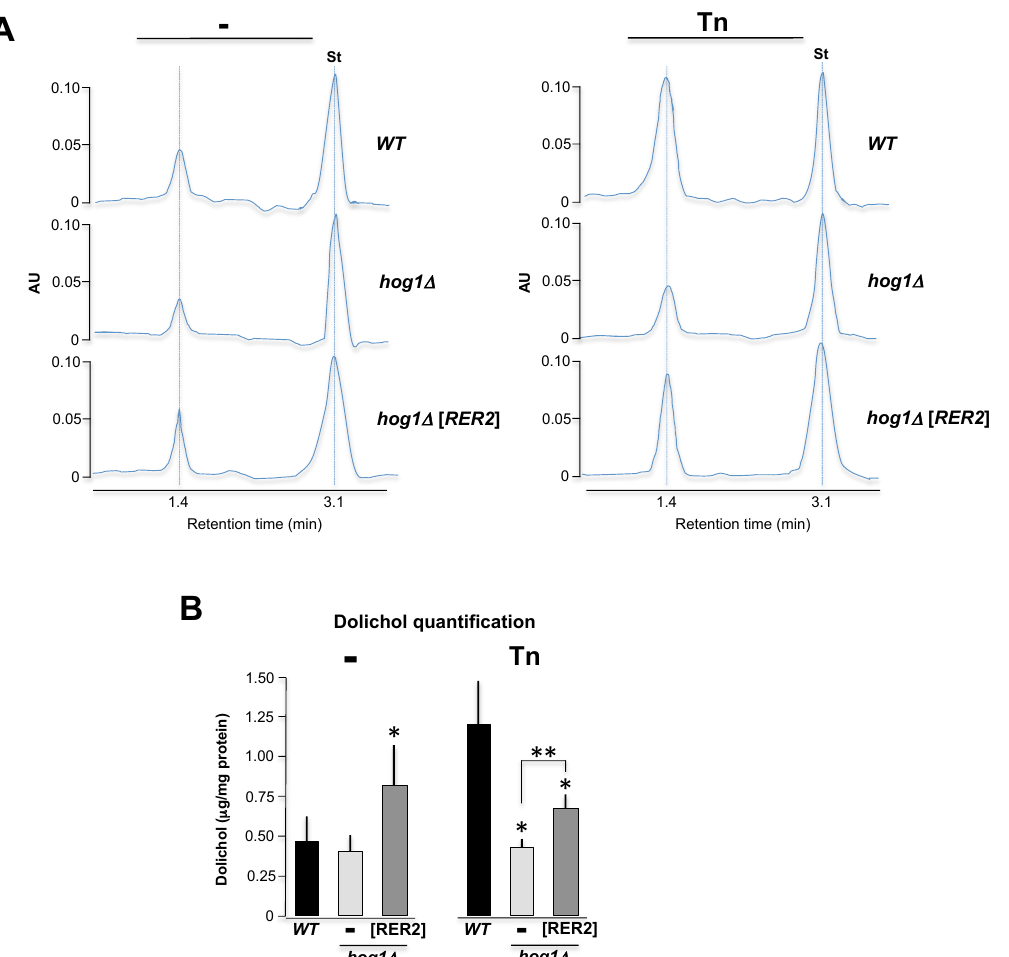
Figure 8. E ff ect of Hog1 inactivation and Tn treatment on the polyprenols concentration. ( A ) HPLC analysis of dolichols isolated from the wild type, hog1 ∆ and hog1 ∆ [ RER2 ] strains, with or without 1 µ g / mL Tn. Dolichol detection was performed by reverse phase HPLC analysis. One representative profile out of three is depicted. 1 µ g / µ L of standard dolichol (18 isoprene units) was included as internal control (St). ( B ) Dolichol concentration was calculated by determining the area under the curve of the dolichol peak relative to the area under the curve of the standard peak (St) and adjusted by protein concentration (See supplemental Table S4). Mean values ( ± SD) were calculated from three independent experiments. One asterisk indicates statistical significance regarding the WT strain. Two asterisks indicate statistical significance between hog1 ∆ and hog1 ∆ [ RER2 ]